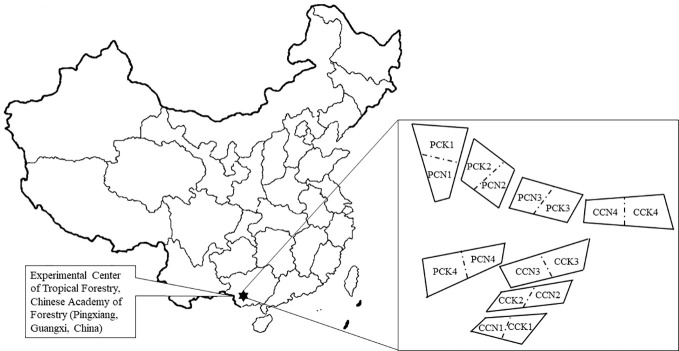
A schematic plot of studying site and experimental design. PCK, PCN, CCK, and CCN represent the pure and close-to-nature managed P. massoniana plantation and the pure and close-to-nature managed C. lanceolata plantation, respectively. Numbers from 1 to 4 represent plot replications. Each plot was 20m×20m.